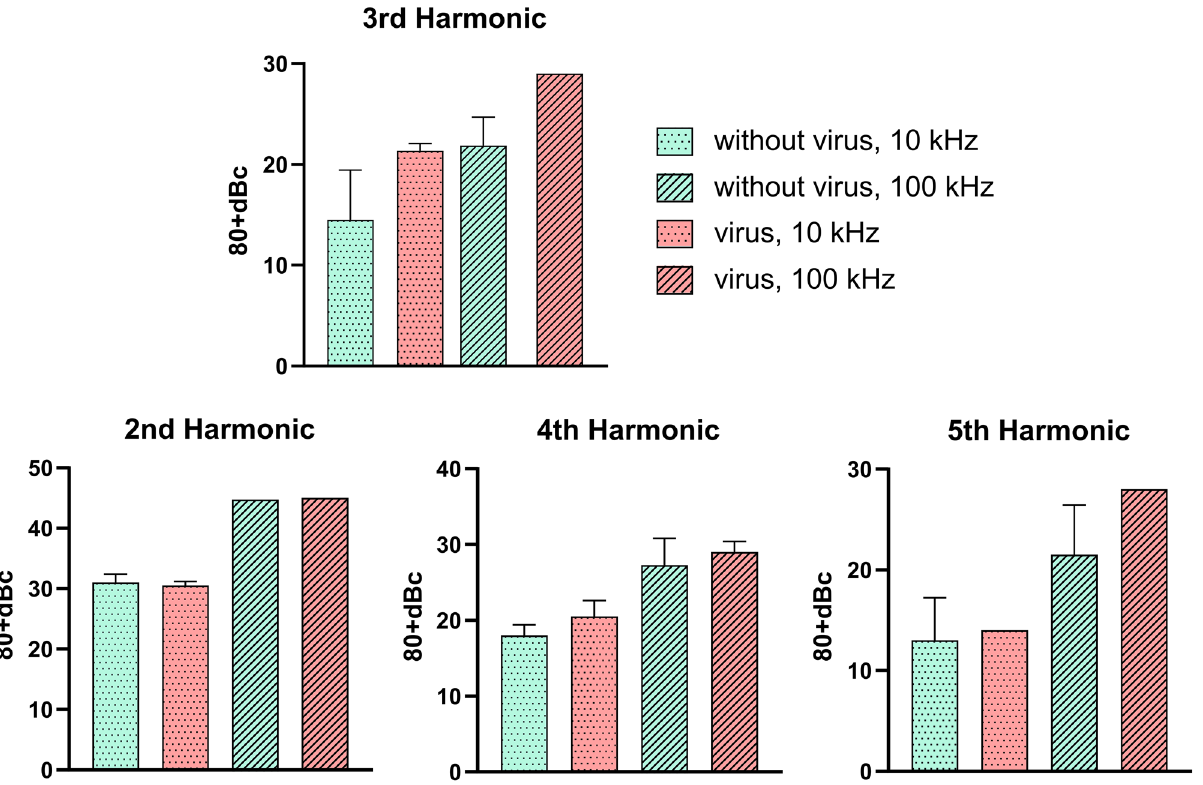
Figure 6. Experimentally measured harmonic levels. Drawings were made using Inkscape version 1.1 and GIMP version 2.10.28 (http:// www. gimp. org, http:// www. inksc ape.